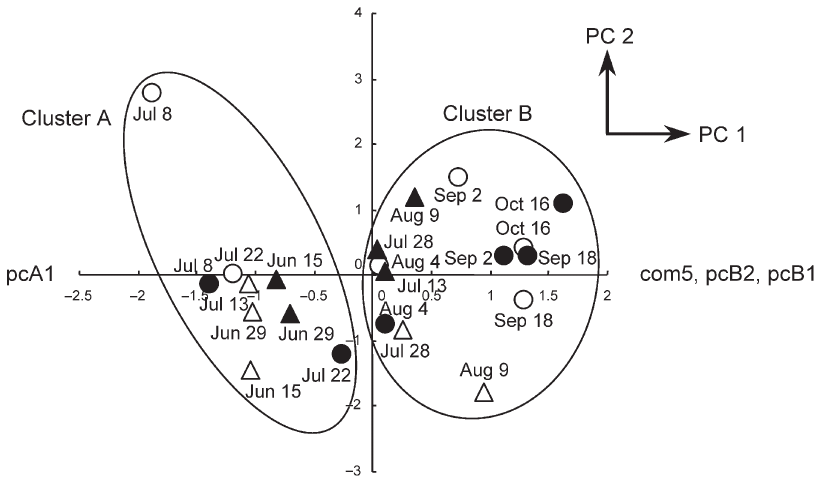
bands; Ikenaga et al. 2004). The similar number of DGGE bands in the leaf sheath and leaf blade indicates that meth- cated on all parts of the rice straw. In contrast, the diversity of blade (Sugano et al. 2005). Seven bands were found in all incu- bations of the sheath and blade samples in Experiments 1 and 2 (Figure 1). No bands were specific to only the leaf sheath or leaf blade. These findings indicate that the part of rice straw buried had little effect on the methanogenic archaeal